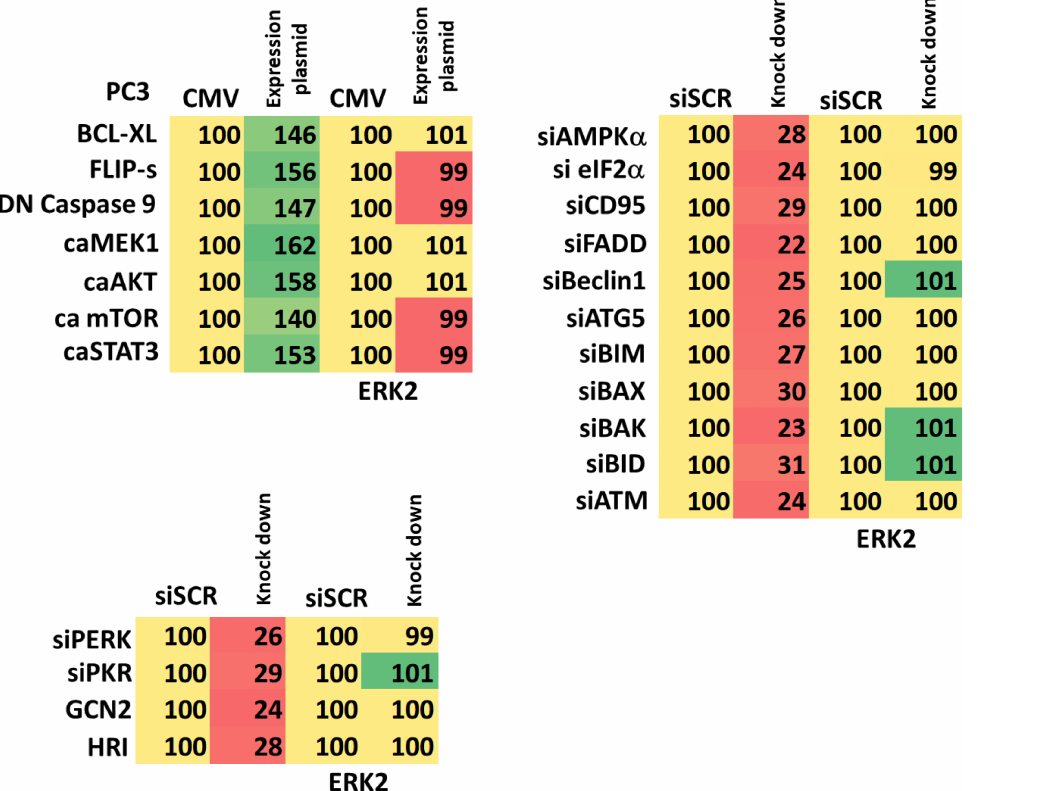
PC3 cells as indicated were transfected with siRNA molecules to knock down the expression of the indicated proteins or transfected with plasmids to over-express the indicated proteins. The percentage remaining after knock-down or the percentage over-expression above basal levels is indicated. (n = 3 +/-SD) (total ERK2 is included as an invariant total protein loading